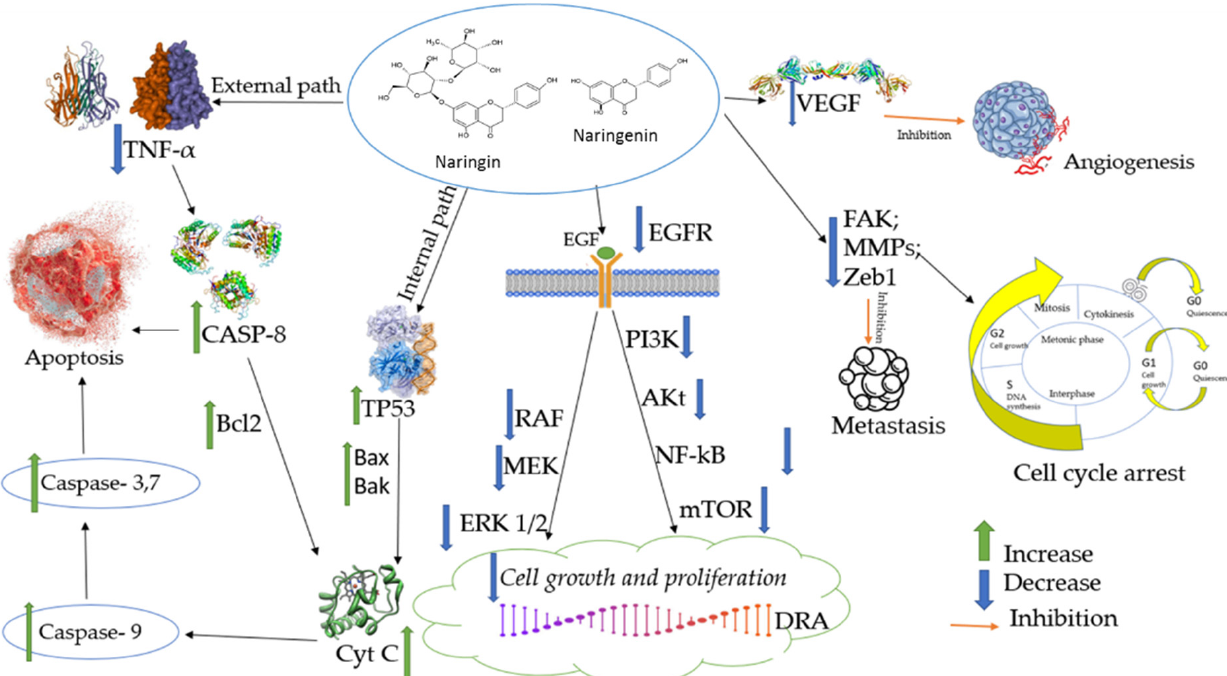
Figure 2. Anticancer effects of naringin and naringenin. VEGF—vascular endothelial growth factor; FAK—focal adhesion kinase, also known as PTK2 protein tyrosine kinase 2; MMPs—matrix metal-